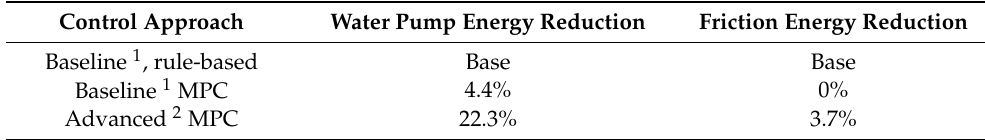
Table 2. Comparison of rule-based and model predictive control approaches for the WLTC with different boundary conditions for the coolant temperature